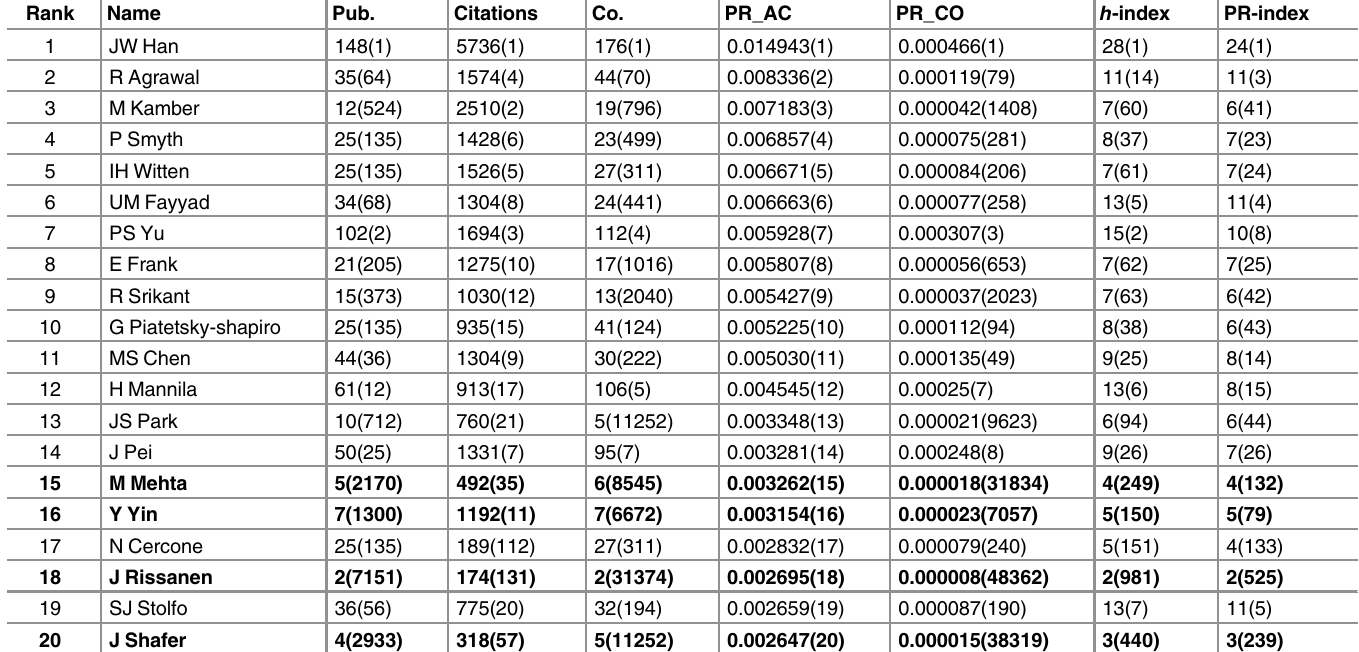
Table 4. Comparison of ranks of the top 20 authors based on the indicator of PR_AC. The authors who are in the boldface may get an inappropriate ranking for they only published a few papers. Numerical in the brackets stands for authors ’ rank according to different indicators. Due to the limitation of table width, there are some abbreviations in this table. The Pub. is short for Publications, Co. is short for